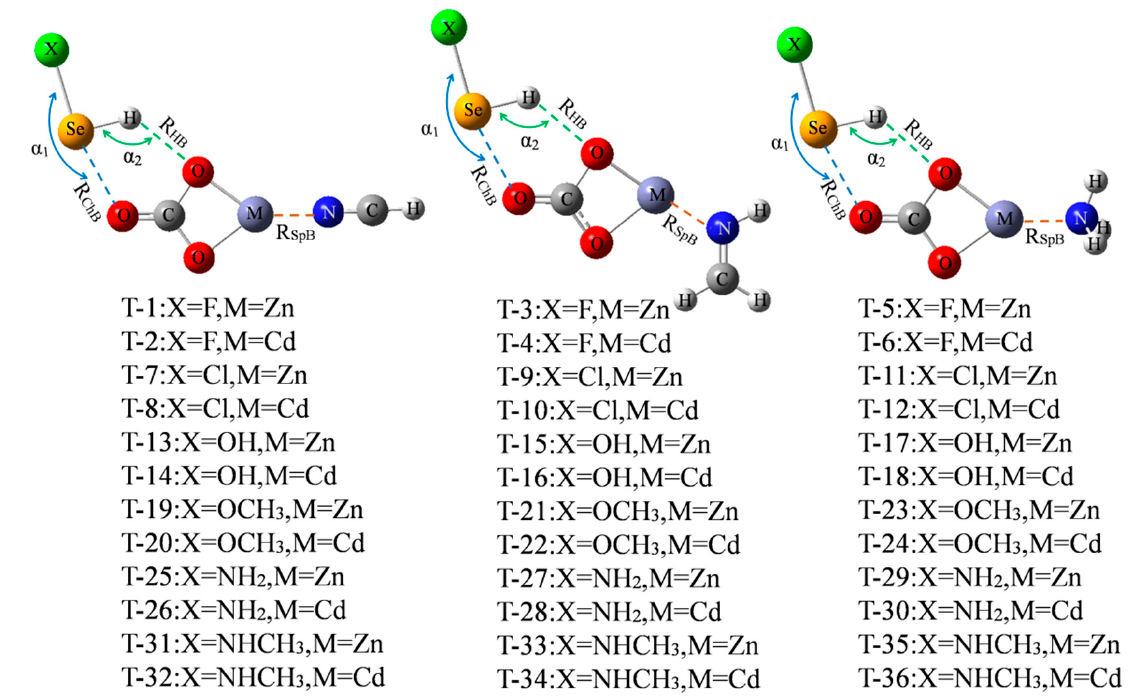
Figure 5. Schemes of XHSe-MCO 3 -N-base ternary complexes.